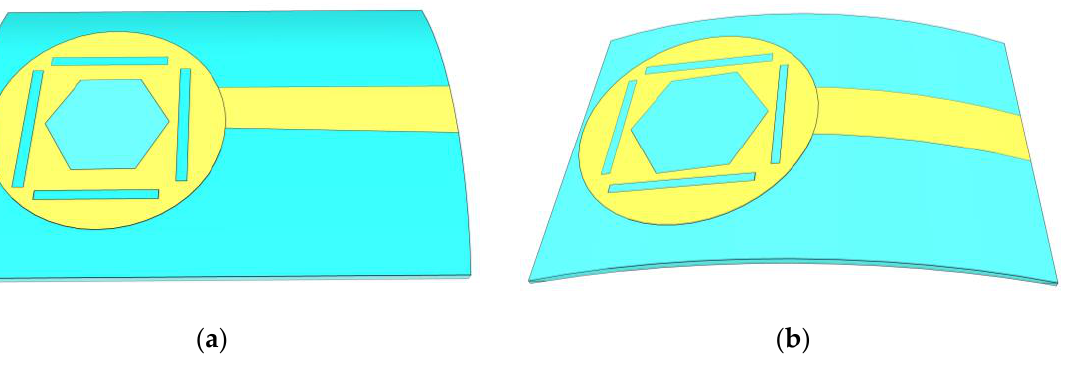
Figure 11. Structural deformation ( a ) X-bend ( b ) Y-bend.